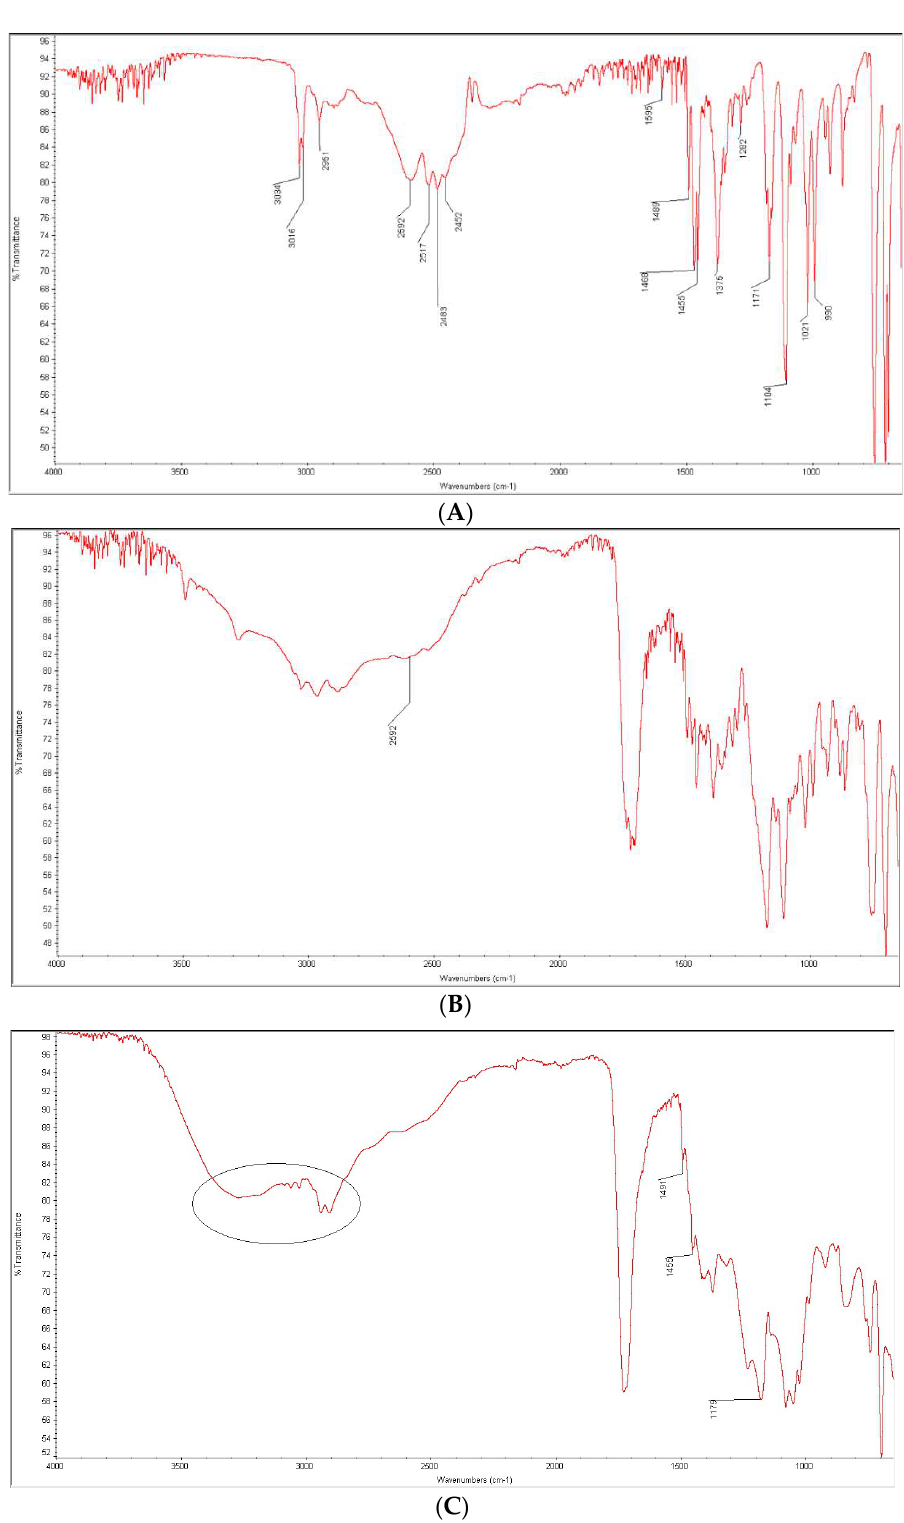
Figure 11. FT-IR spectra of diphenhydramine (DIPH) as a bulk ( A ) and in the mixtures with citric acid (CA): the non-stressed mixture ( B ) and the mixture stressed with high temperature and humidity ( C ).